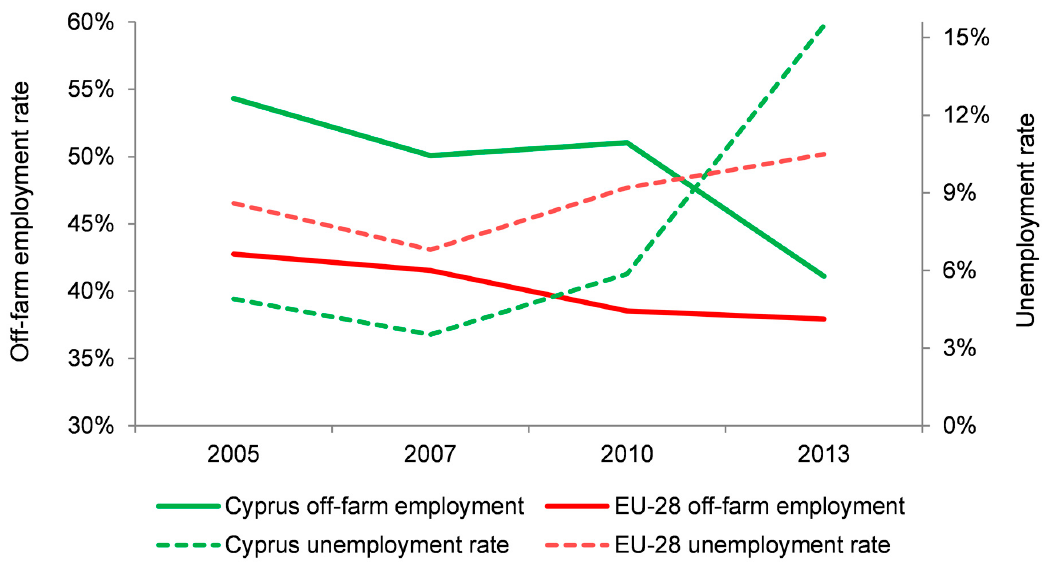
Figure 1. Cyprus and European Union (EU)-28 off-farm employment and unemployment rates, 2005–2013. Sources: European Commission [14]; Eurostat [15].